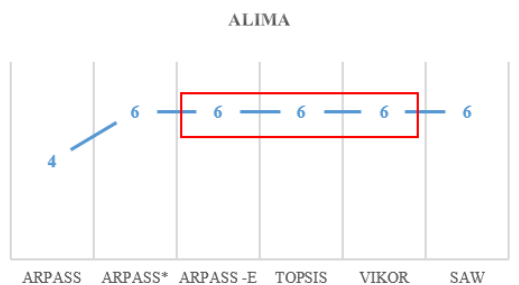
Figure 16. Rank fluctuation of Alima in the investigated MCDM methods.